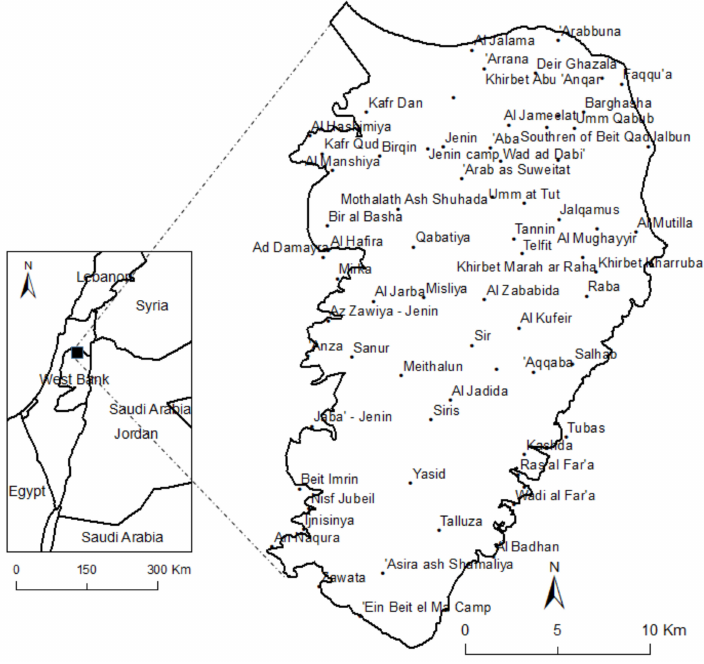
Figure 1. Regional location of the Eocene aquifer along with its